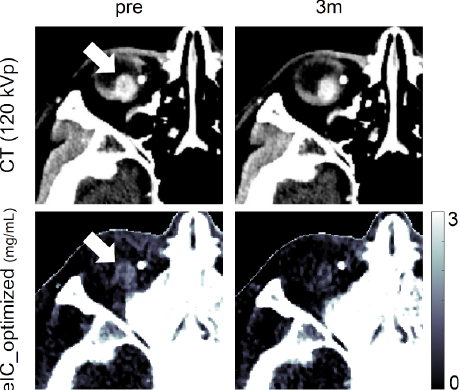
Figure 5. The changes in indices during charged-particle radiation therapy. In comparison with the pre-treatment values, the ( a ) tumor volume and ( b ) computed tomography values (80, 140, 120 kVp) significantly reduced at 1.5–2 years post-treatment, but none of these parameters showed significant changes at 3 months after treatment. ( c ) On the other hand, the eIC_optimized showed significant reductions at both 3 months post-treatment and 1.5–2 years post-treatment.